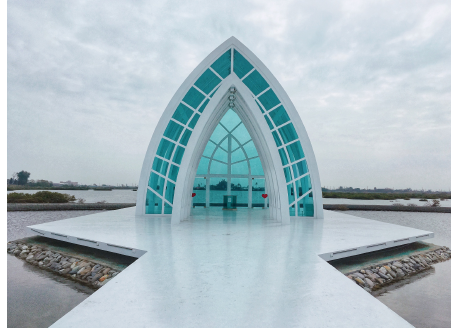
Figure 10. An example image following the triangle composition